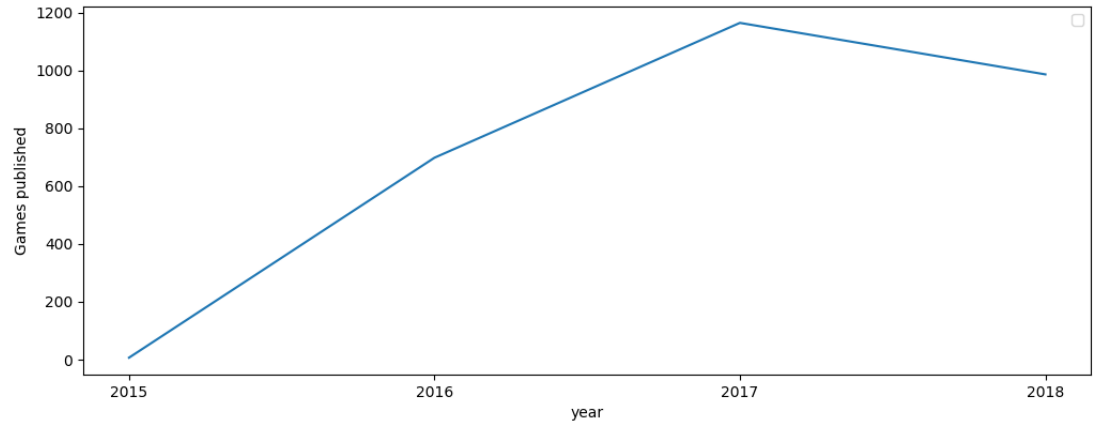
Figure 5. Evolution of games published in